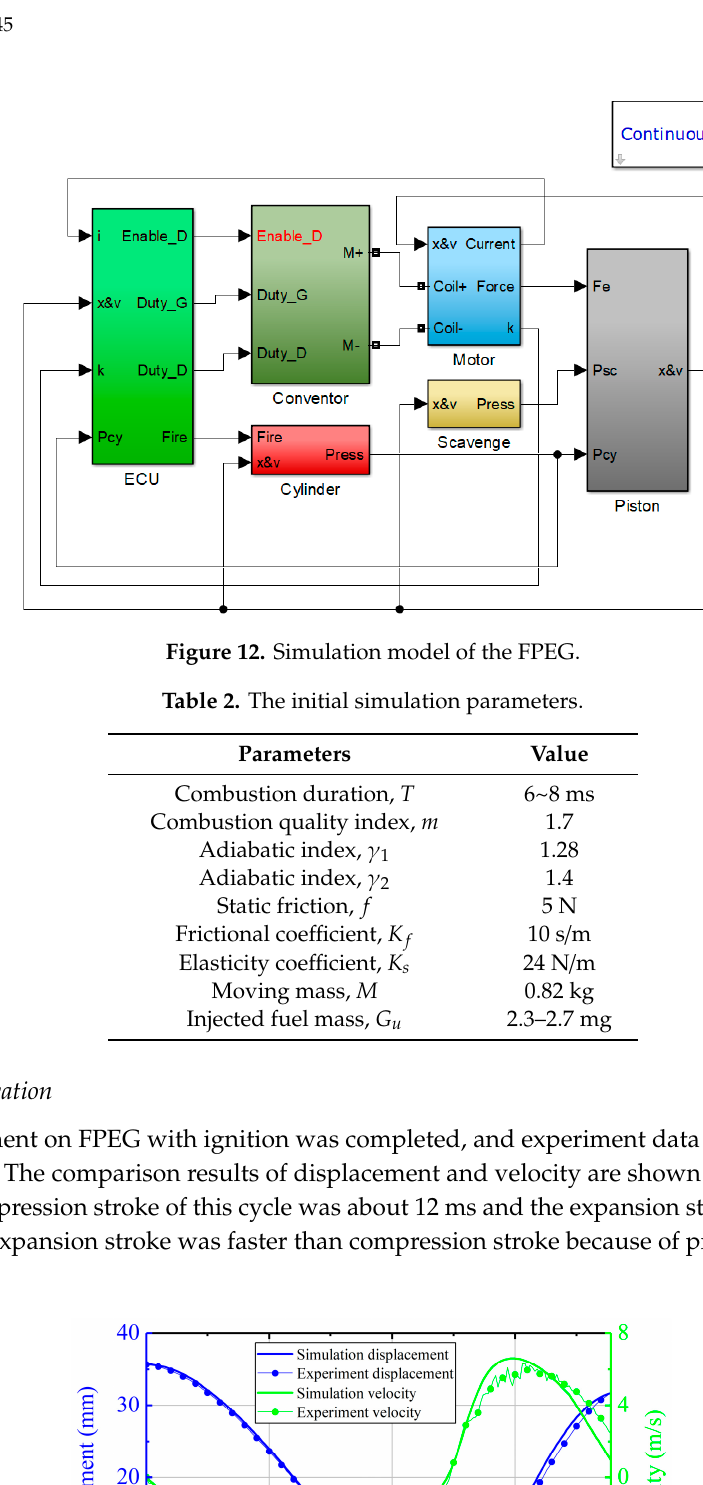
Figure 14. The in-cylinder pressure verification (stable operation). The linear electric machine worked as a generator both in compression stroke and combustion stroke during stable operation. The generating current of the cycle is shown in Figure 15, the current